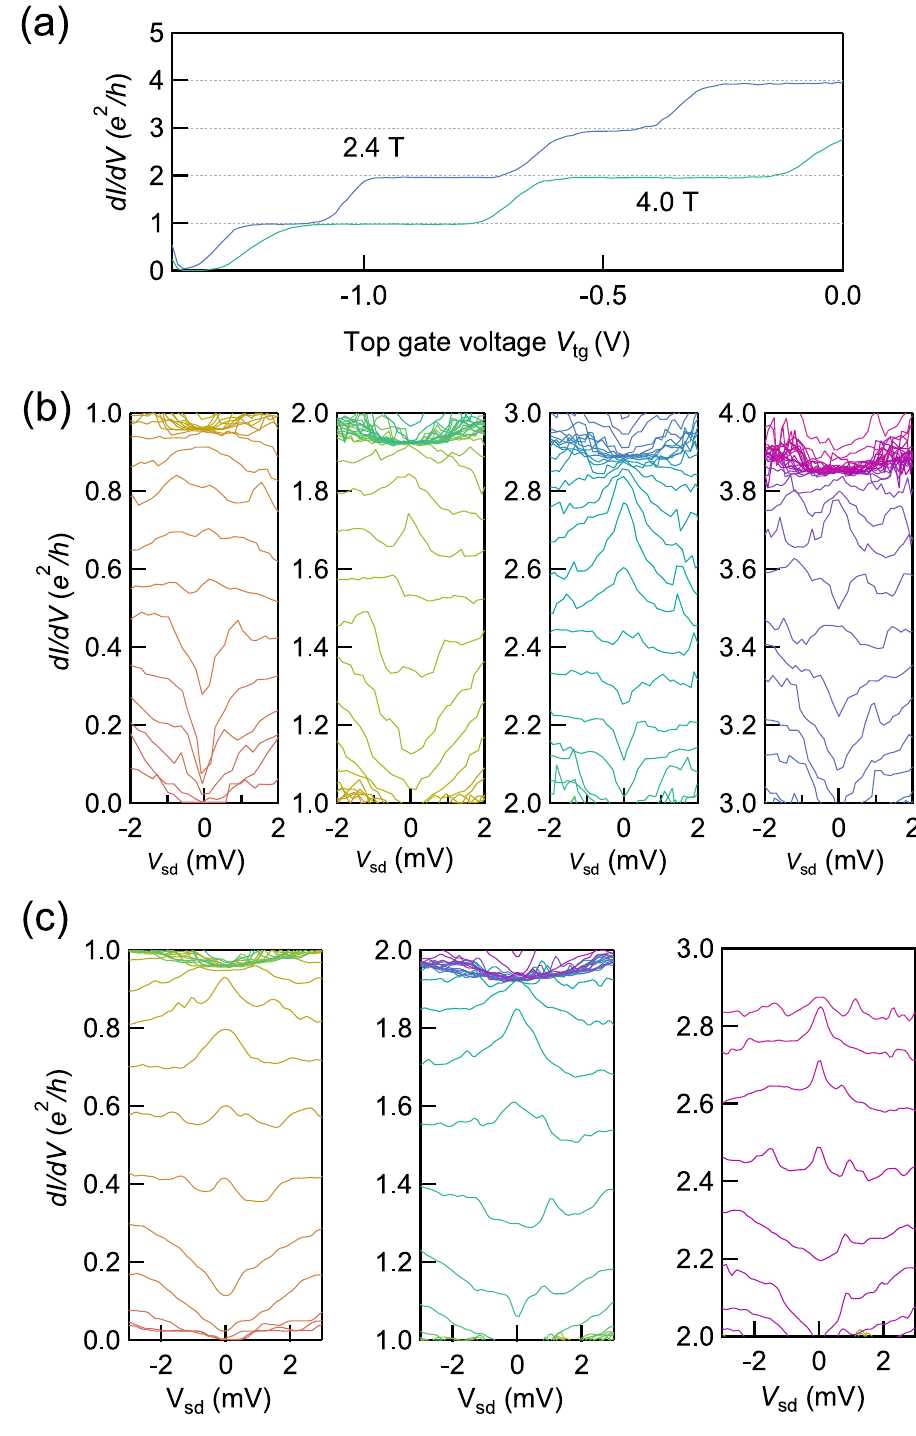
Figure 2. Measured spin-resolved QH effect ane sub-gap features on the QH plateau transition regimes at B = 2.4 T and 4 T. ( a ) dI / dV vs. V tg at 2.4 T and 4.0 T with V sd = 0 V. The conductance plateaus are clearly observed on 1, 2, 3, and 4 × e 2 / h . This indicates the Zeeman energy at 2.4 T is enough to resolve the spin degeneracy. ( b ) Measured dI / dV vs. V sd at 2.4 T for − 1.5 V < V tg < 0 V, divided into four panels to clarify the V sd dependence in each plateau-transition regime. dI / dV has a dip structure around V sd = 0 V for ne 2 / h < dI / dV < ne 2 / h + 0.5. In contrast dI / dV has a peak structure for ne 2 / h + 0.5 < dI / dV < ne 2 / h + 0.8. ( c ) Measured dI / dV vs. V sd at 4.0 T for − 1.5 V < V tg < 0 V divided into three panels. The features are similar to those observed in the results obtained at 2.4